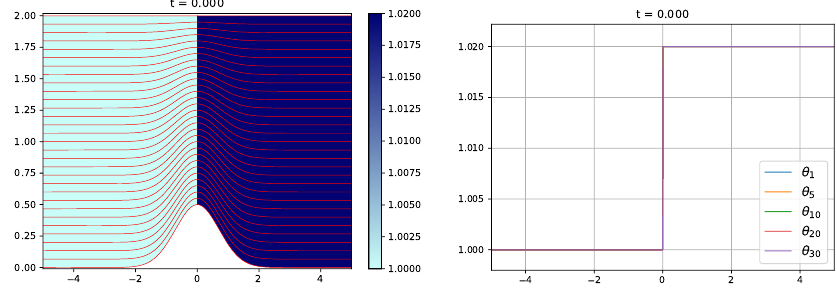
Figure 28. Initial